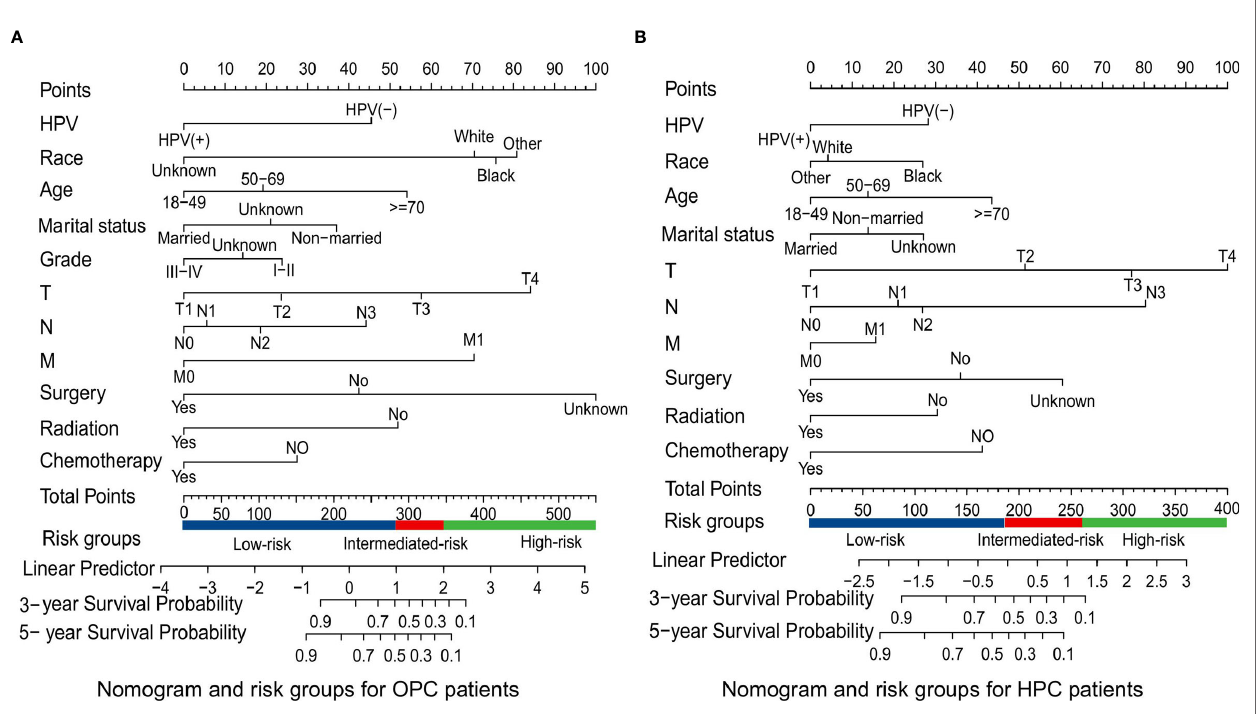
FIGURE 3 | Survival nomograms and risk groups for OPC and HPC patients. (A) Prediction of the 3- and 5-year OS in OPC patients and the risk groups based on the total points of each OPC patient in the training cohort; (B) Prediction of the 3- and 5-year OS in HPC patients and the risk groups based on the total points of each HPC patient in the training cohort. OS, overall survival; OPC, oropharyngeal carcinoma; HPC, hypopharyngeal